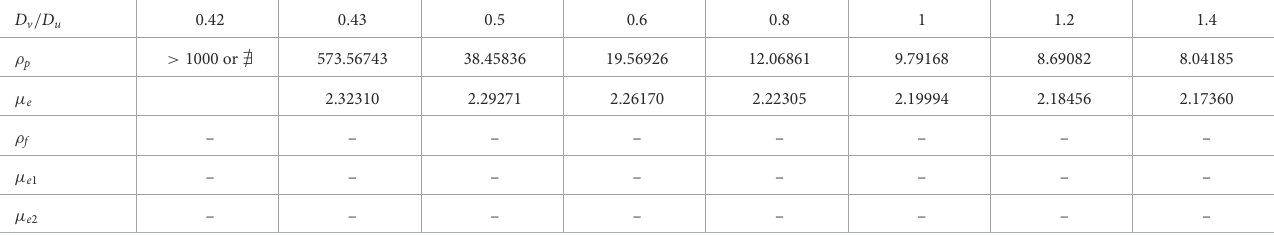
TABLE 2 Decreasing the ratio D v / D u does not trigger hysteresis when d u = 0.09, but rather there is a minimum threshold of the diffusivity ratio where the symmetry-breaking pitchfork bifurcation point